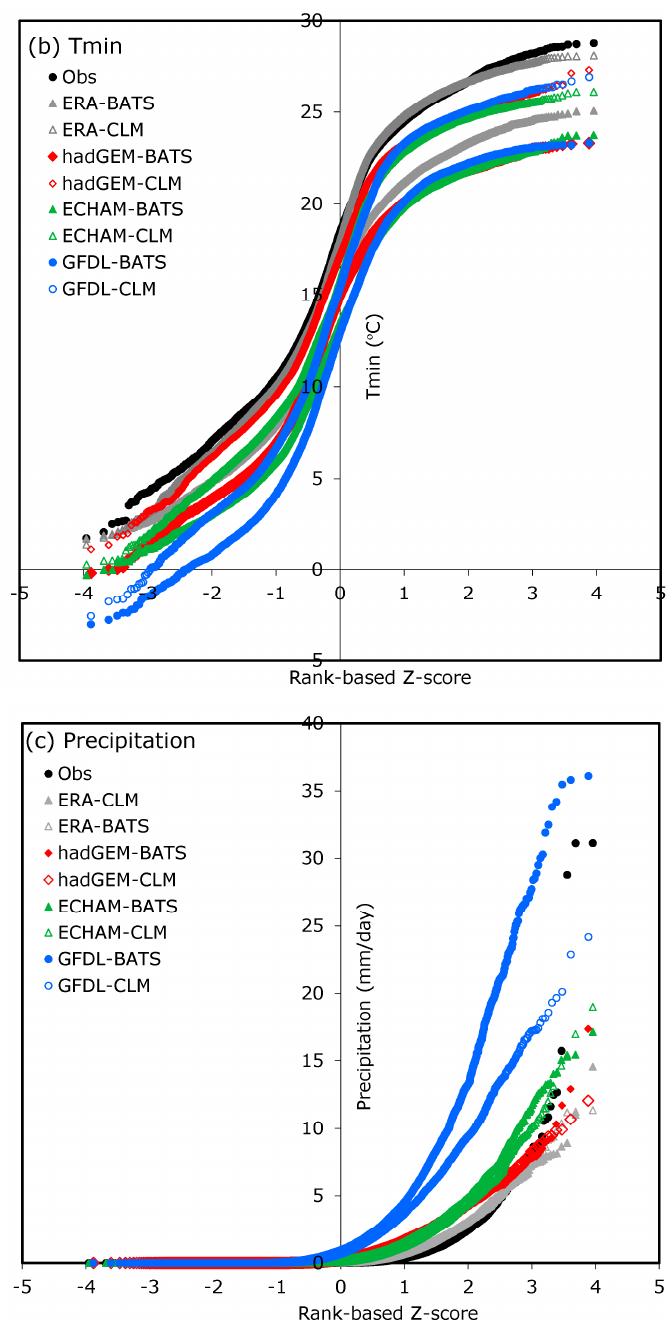
Figure 16. Normal Quantile Plot for daily data of ( a ) maximum temperature (Tmax), ( b ) minimum temperature (Tmin), and ( c ) Precipitation for three CMIP5 models, reanalysis ERA-Int and surface observations for the period